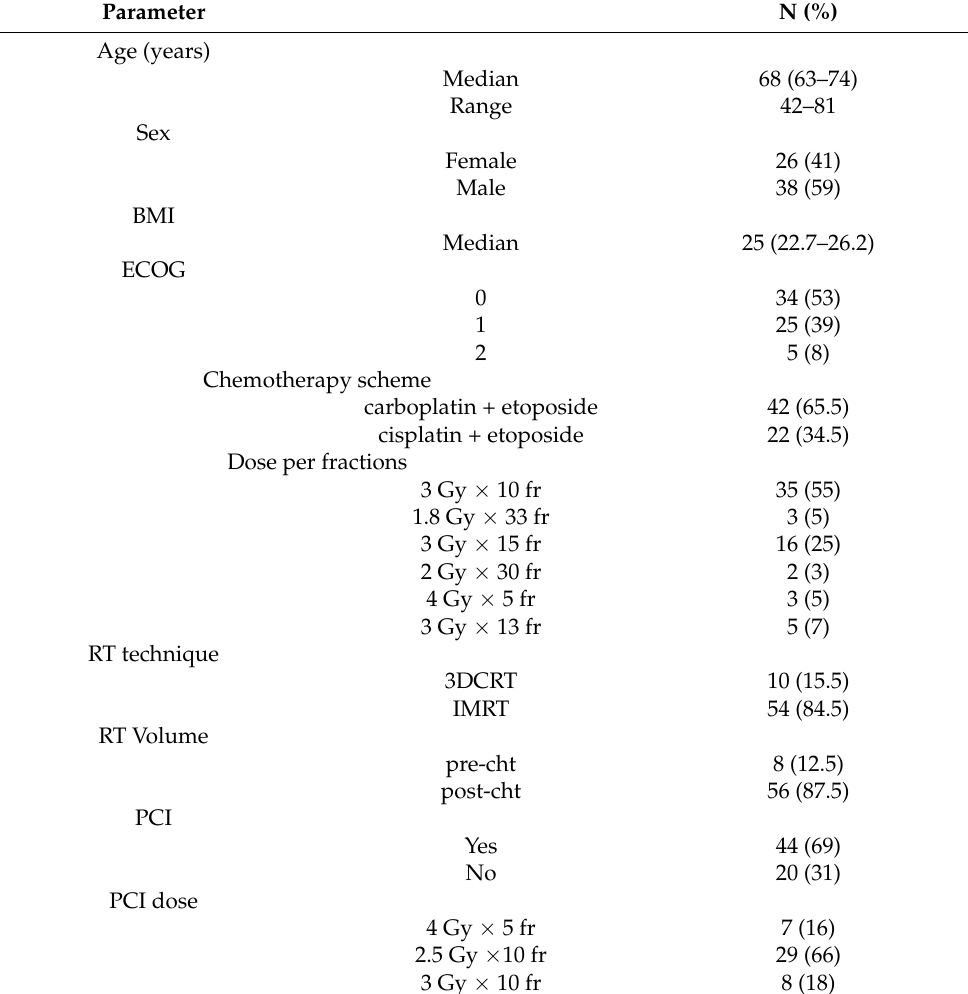
Table 1. Characteristics of the study